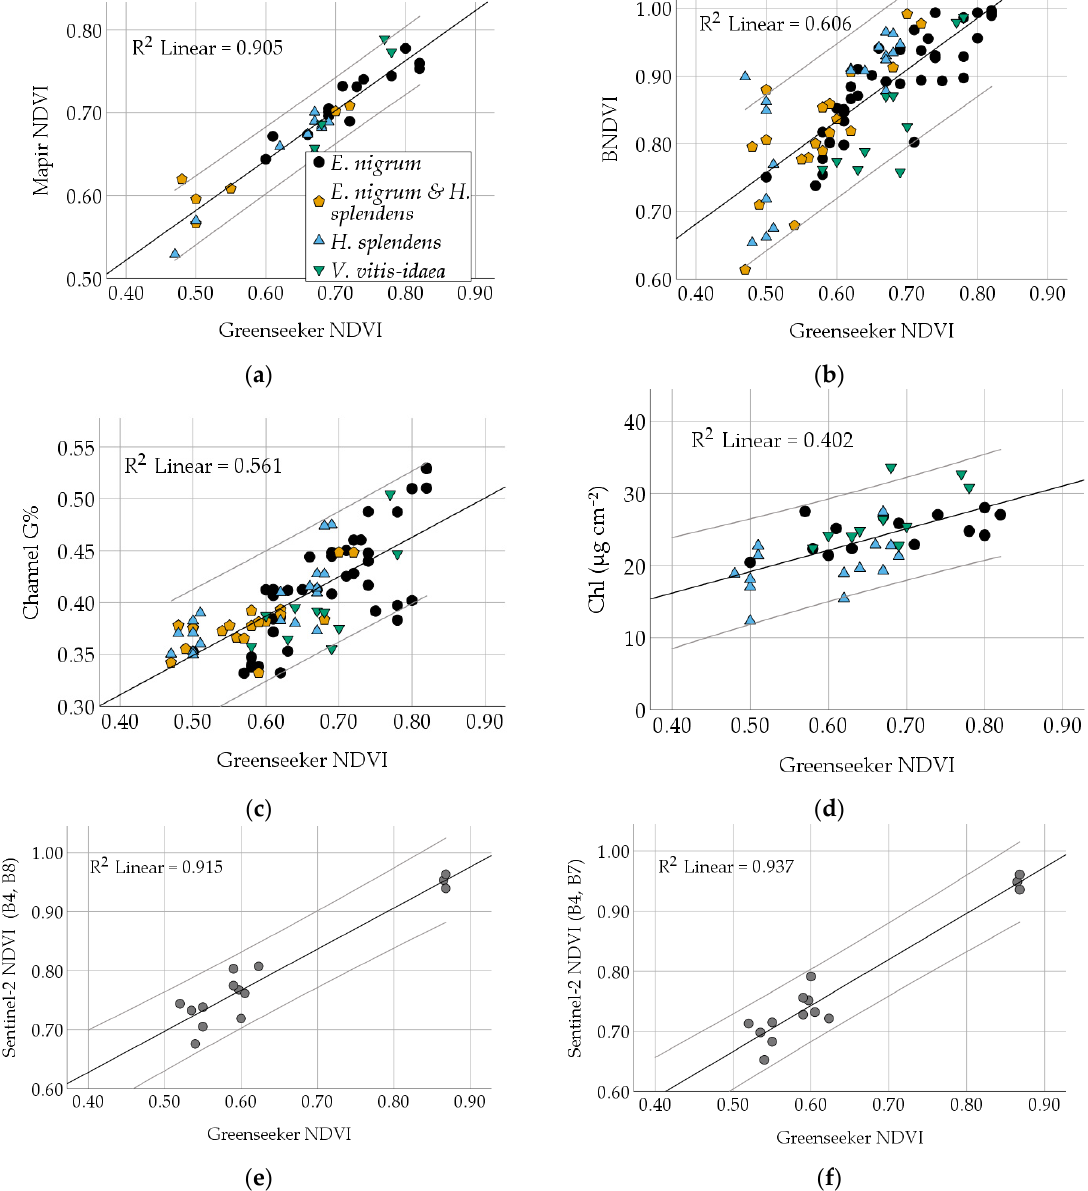
Figure 1. Species are marked with different symbols (see legend). 95% confidence intervals are grey. All correlations are significant ( p < 0.001). The panels show the relationships between: ( a ) The active Greenseeker and the passive Mapir NDVI; ( b ) the BNDVI from the modified camera and NDVI; ( c ) Channel G% from the ordinary camera and NDVI; ( d ) chlorophyll content (Chl) and NDVI; ( e ) and ( f ) represent our satellite upscaling; comparing ground-based Greenseeker NDVI and Sentinel-2 NDVI, (note n = 14 ). NDVI is calculated with the named bands ( = B). Equations and RMSE are shown in Table S4. Joint analyses of all plant species resulted in variable correlations between the greenness indices and other plant traits, i.e. SLA, chlorophyll content, and plant height (Table 4). The nitrogen index (NBI) shows